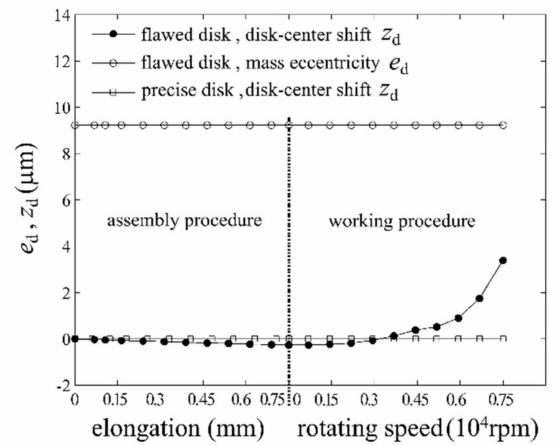
Figure 6. Disk–centre shift z d and mass eccentricity e d of the flawed disk during assembly and working procedure.